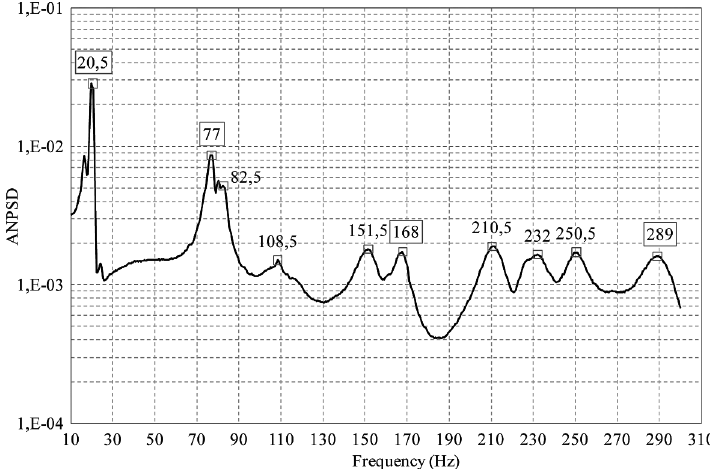
Fig. 8. Averaged normalized power spectral density